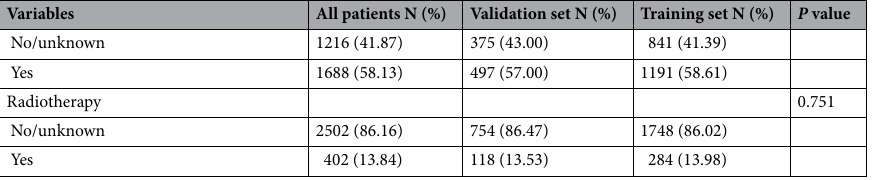
Table 1. Patient demographics and pathological